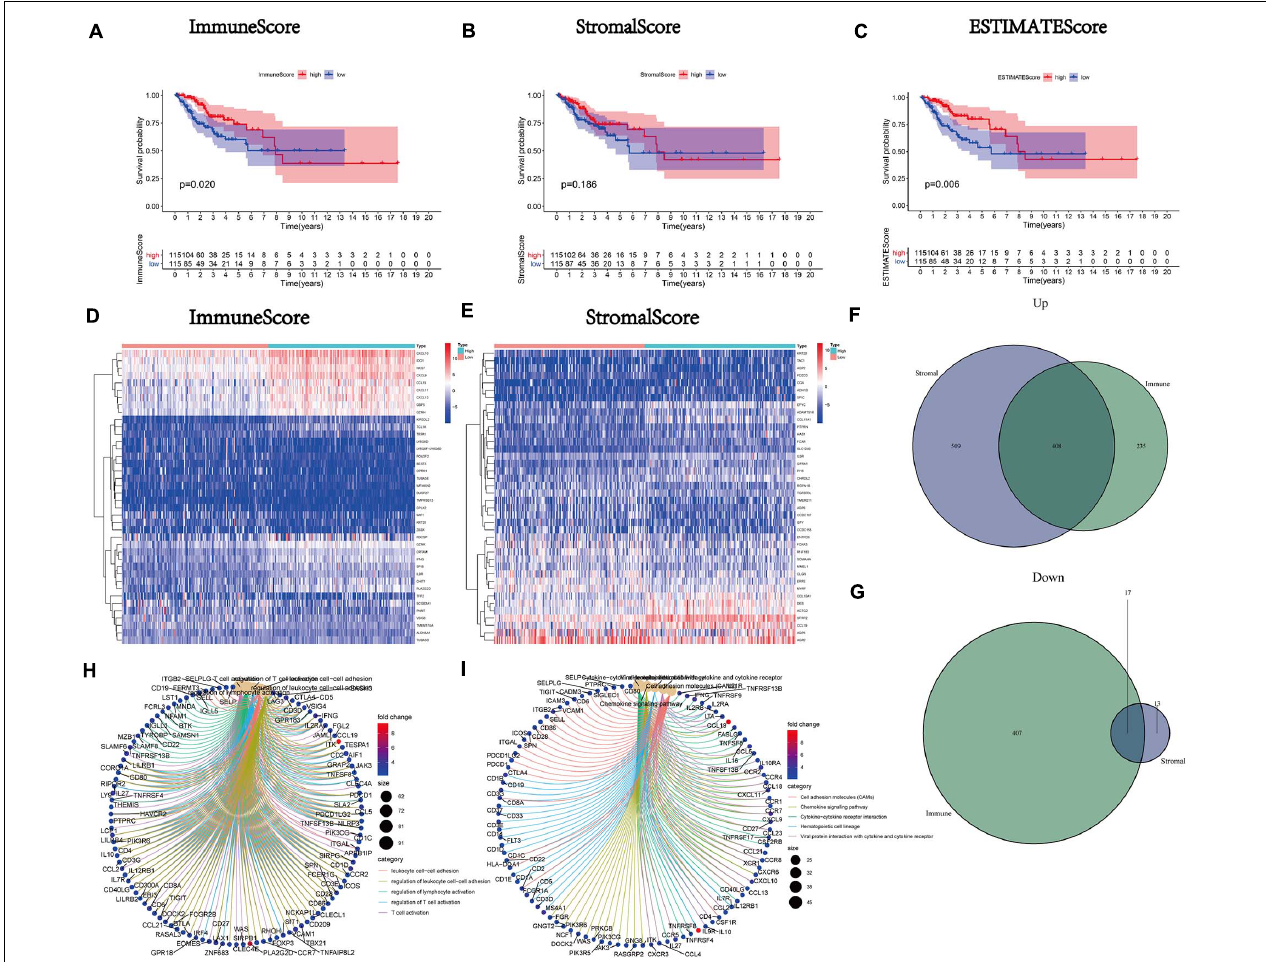
FIGURE 2 | Correlation of scores with the survival of patients with cervical cancer (CC) and heatmaps, Venn plots, and enrichment analysis of Gene Ontology (GO) and Kyoto Encyclopedia of Genes and Genomes (KEGG) for differentially expressed genes (DEGs). (A) Kaplan–Meier survival analysis (ImmuneScore) for patients with CC classified into high- or low-score groups determined by comparison with the median. p = 0.020 by the log-rank test. (B) Kaplan–Meier survival curve for the StromalScore with p = 0.186 by the log-rank test. (C) Survival analysis using the Kaplan–Meier method for patients with CC grouped based on the ESTIMATEScore with p = 0.006 by the log-rank test. (D) Heatmap for DEGs generated by comparison of the high-score group versus the low-score group (ImmuneScore). Rows of the heatmap indicate the gene names, while columns denote the ID of samples which are not shown in the plot. Differentially expressed genes were determined by the Wilcoxon rank-sum test with q = 0.05 and fold-change > 1 after log 2 transformation as the significance threshold. (E) Heatmap for DEGs according to the StromalScore, similar to (D) . (F,G) Venn plots showing common upregulated and downregulated DEGs shared according to the ImmuneScore and StromalScore, and q < 0.05 and fold-change > 1 after log 2 transformation as the DEG significance filtering threshold. (H,I) GO and KEGG enrichment analysis for 425 DEGs; terms with p and q < 0.05 were considered significantly